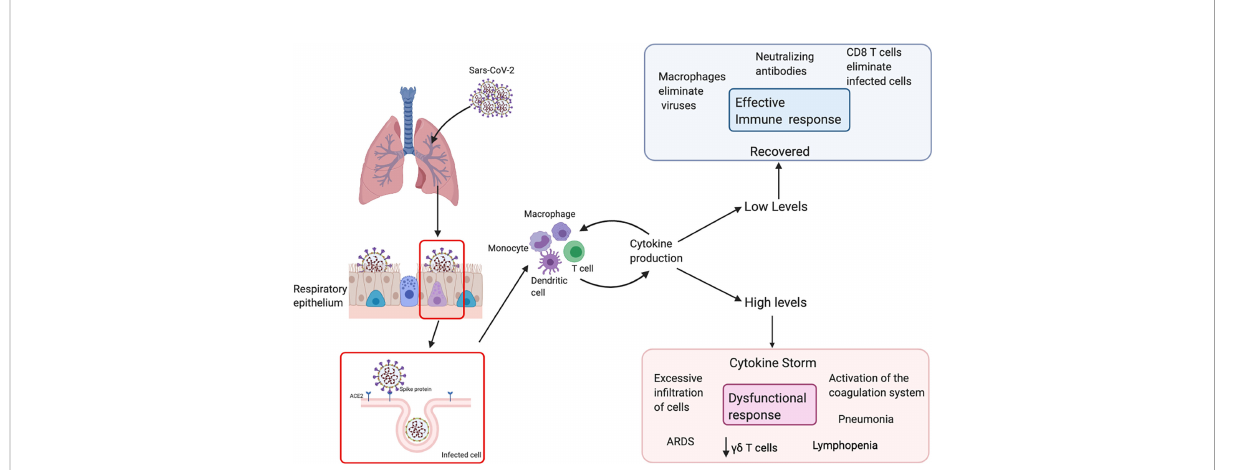
FIGURE 2 Schematic immune responses to SARS-CoV-2. The SARS-CoV-2 virus recognizes ACE-2 in respiratory epithelial cells, facilitating viral entry. After viral replication, the virus is released and recognized by the immune system. T cells and dendritic cells are activated through pattern recognition receptors. The virus induces the expression of numerous in fl ammatory factors, the synthesis of type I interferons and production of cytokines. High levels of cytokines cause a cytokine storm, which leads to a dysfunctional response with an excessive in fi ltration of cells, decrease in different populations of T cells in the blood such as gd T cells and surviving T cells are immunologically exhausted, this provokes progression to acute respiratory distress syndrome